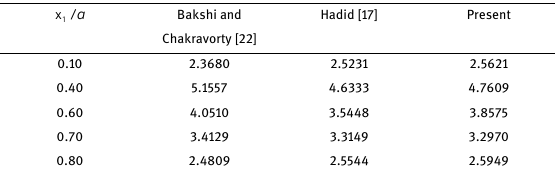
Table 2: Comparison of deflection (x10 −2 ) of simply supported isotropic conoid under uniformly distributed load along y / b = 0.5 .